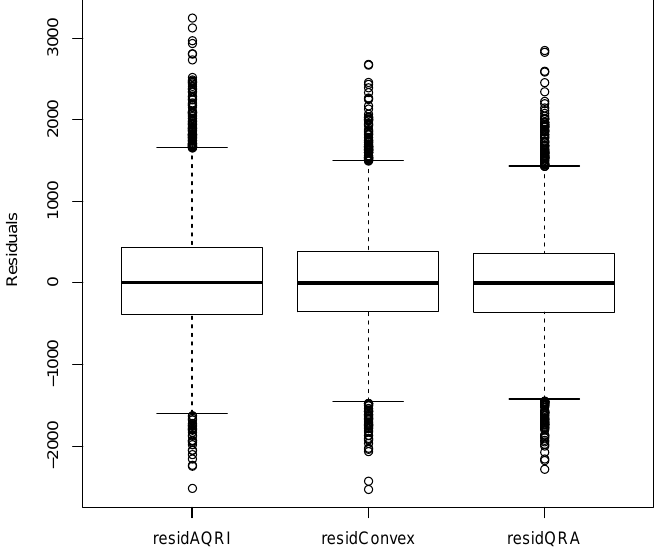
Figure 8. Box plots of residuals from models M 4 (residAQRI), M 5 (residConvex) and M 6